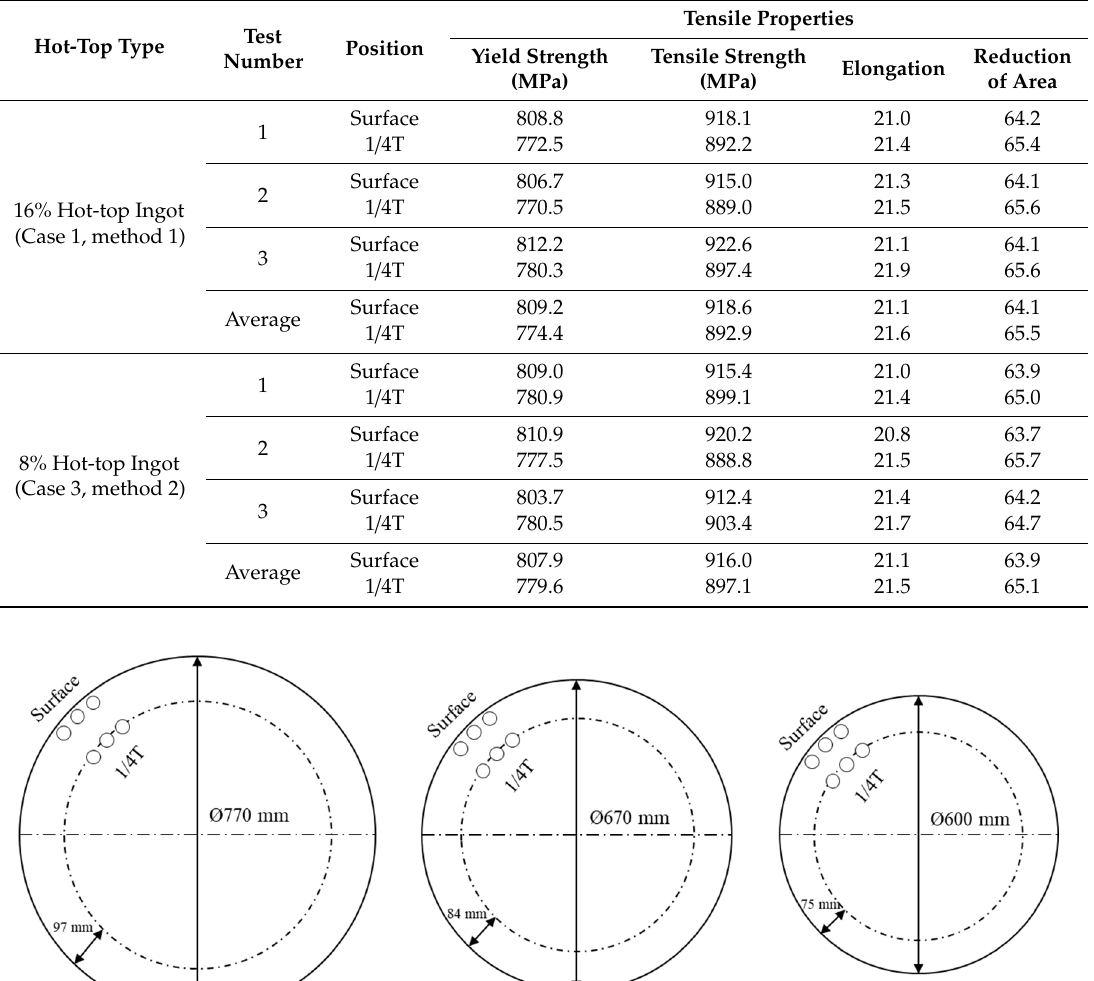
Figure 13. Microstructures at position 1/4T of the ( a ) 16% hot top; ( b ) 8% hot top. Table 7. Mechanical properties of the main shafts after the quenching–tempering heat treatment.